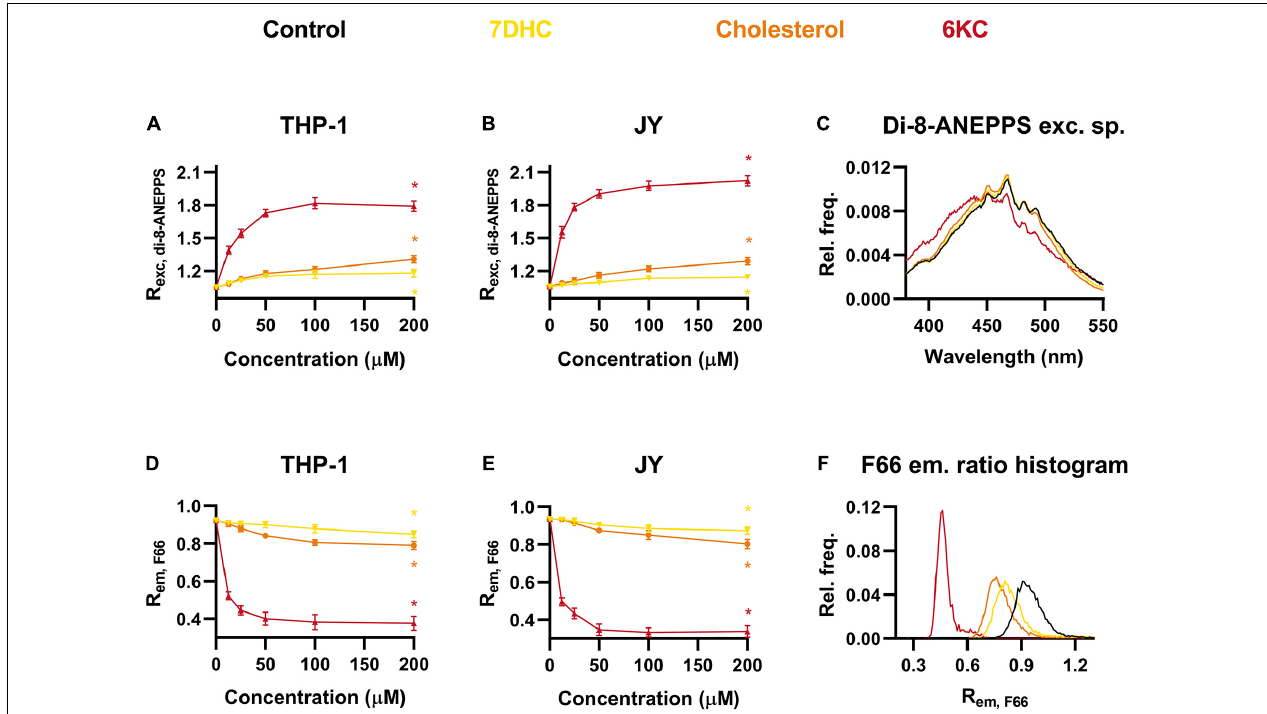
FIGURE 2 | Effects of 7-dehydrocholesterol (7DHC), cholesterol and 6-ketocholestanol (6KC) on the magnitude of dipole potential. THP-1 (A) or JY cells (B) were treated with 7DHC, cholesterol or 6KC at various concentrations between 12.5 and 200 µ M and labeled with di-8-ANEPPS, which was followed by determination of the dipole potential-sensitive excitation ratio (R exc , di − 8 − ANEPPS ) using spectrofluorometry. R exc , di − 8 − ANEPPS values were calculated from fluorescence intensities integrated between excitation wavelengths 410–440 nm and 490–520 nm and the mean ( ± SD) values of five independent experiments were plotted as a function of the applied concentrations of 7DHC (yellow), cholesterol (orange) and 6KC (red). Representative excitation spectra display shifts induced by the various sterols compared to controls (black) (C) . Alternatively, control THP-1 (D) or JY (E) cells and those treated with 7DHC, cholesterol or 6KC were labeled with F66 and the emitted fluorescence intensities of individual cells were measured in the wavelength ranges 470–490 nm and 564–606 nm and the mean intensity ratio (R em , F 66 ) was calculated from data of at least 20,000 living cells per sample. The average values of five independent measurements ( ± SD) were plotted as a function of the applied concentrations of 7DHC, cholesterol and 6KC. Representative histograms containing data of individual cells display the shifts in R em , F 66 values in response to the different sterols compared to controls (F) . Asterisks (*) indicate significant differences obtained at maximal treatment concentrations compared to control samples ( p < 0.05, ANOVA followed by Tukey’s HSD